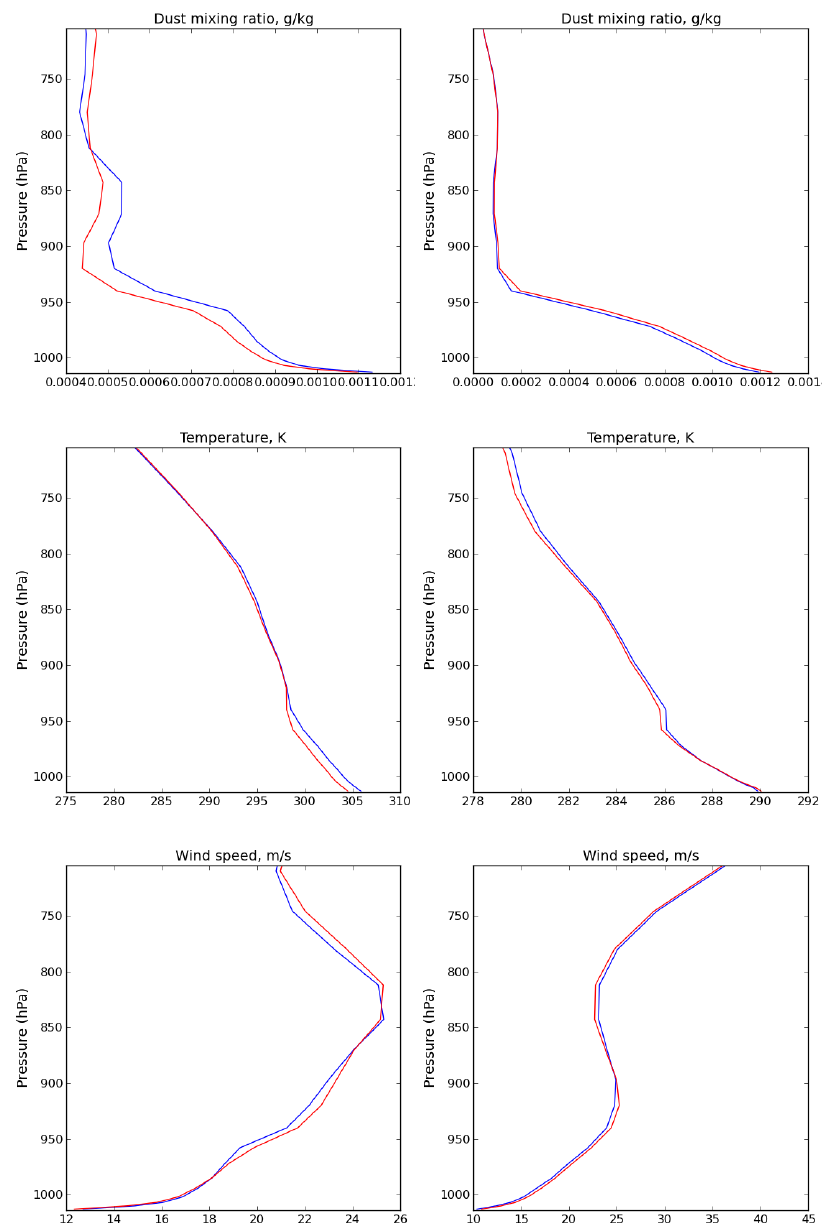
Figure 14. Vertical profile of dust mixing ratio (top), temperature (middle) and wind speed (bottom) at Siwa Oasis. Forecasts starting on 17 April 2012, 00:00UTC, lead time 15h (left) and 27h (right). REF is in blue, TOTAL in